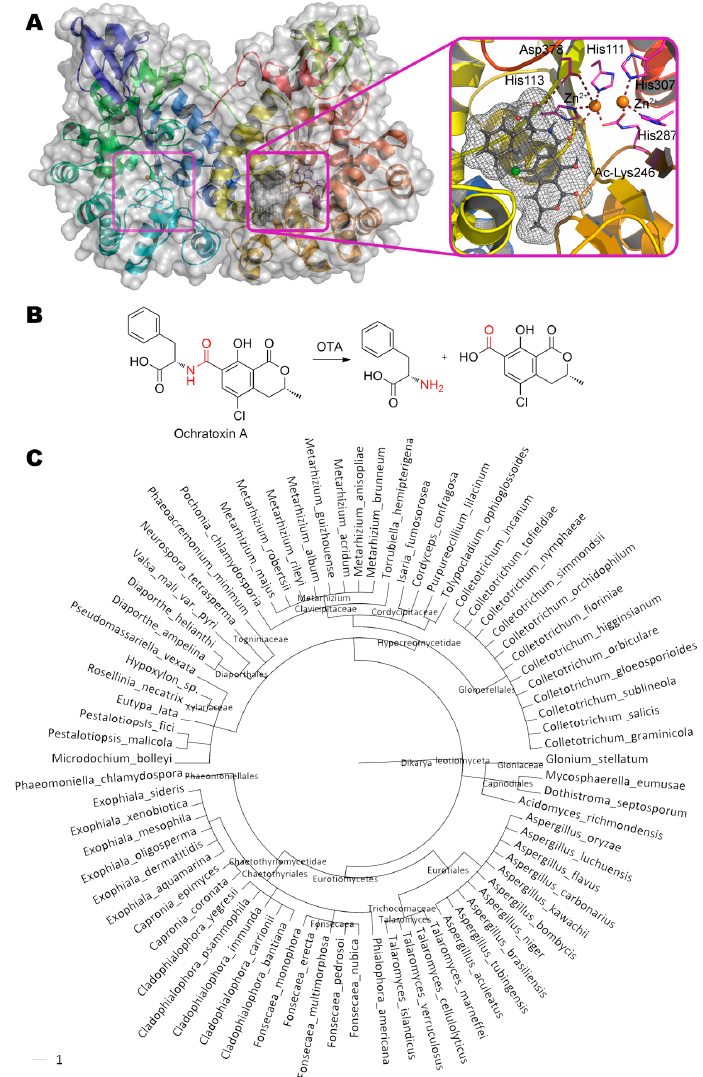
Figure 6. ( A ) Structure of ochratoxinase OTase (PDB 4c5y) containing ochratoxin A in its active center, and ( B ) scheme of substrate conversion with OTase. Position and geometry of substrate binding was determined as described early. ( C ) Phylogenetic tree of microorganisms possessing homologous enzymes found with BLAST.